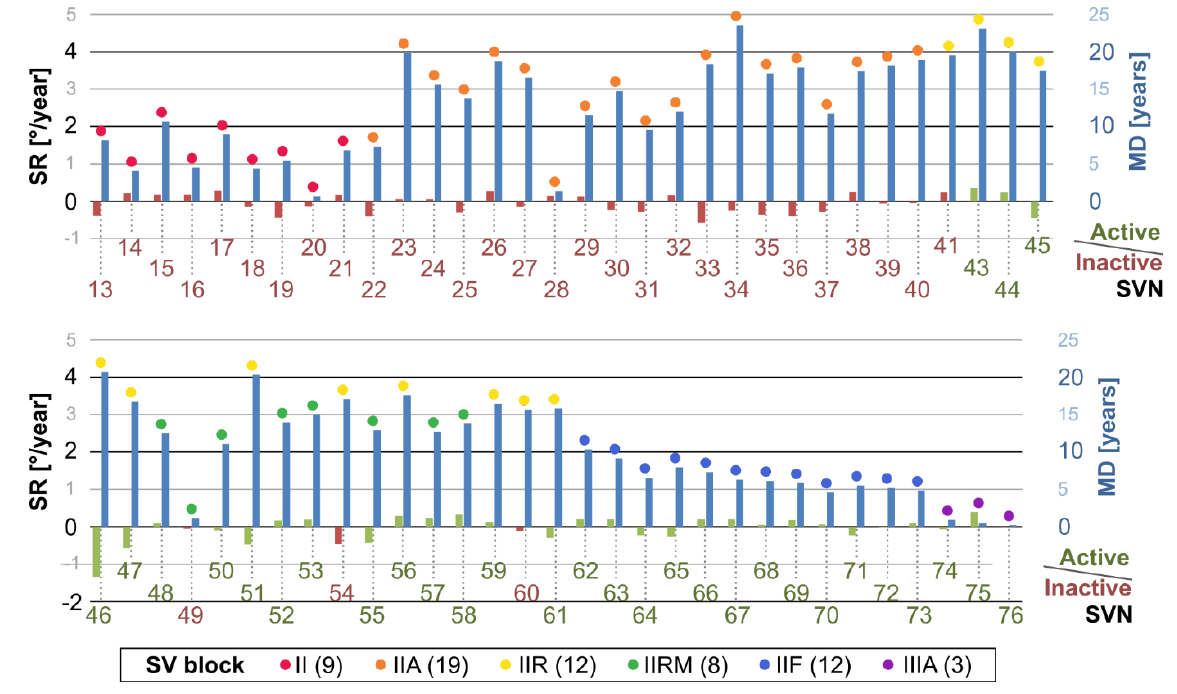
The plot has two vertical scales. The scale on the left shows the rate of separation (SR) of